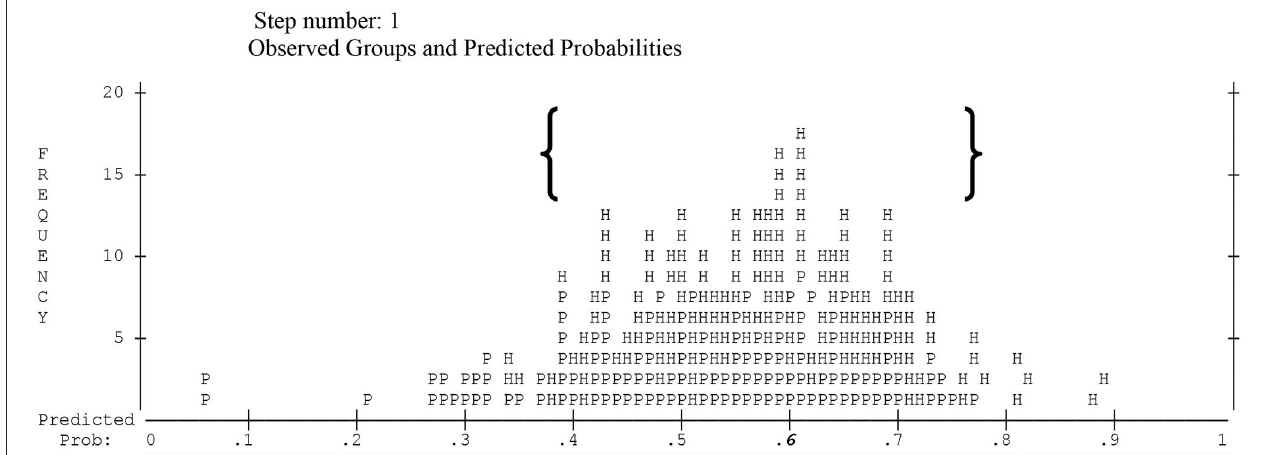
FIGURE 4 | Classification graphical plot of